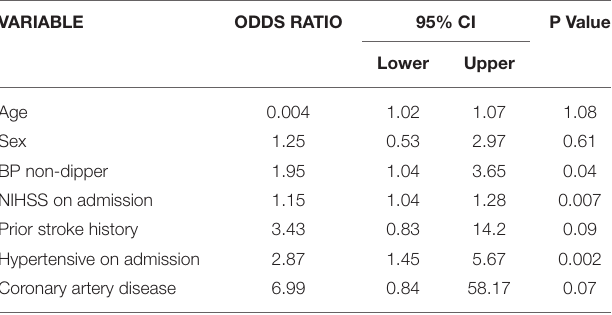
TABLE 4 | Multivariate analysis of the variables associated with SVD.